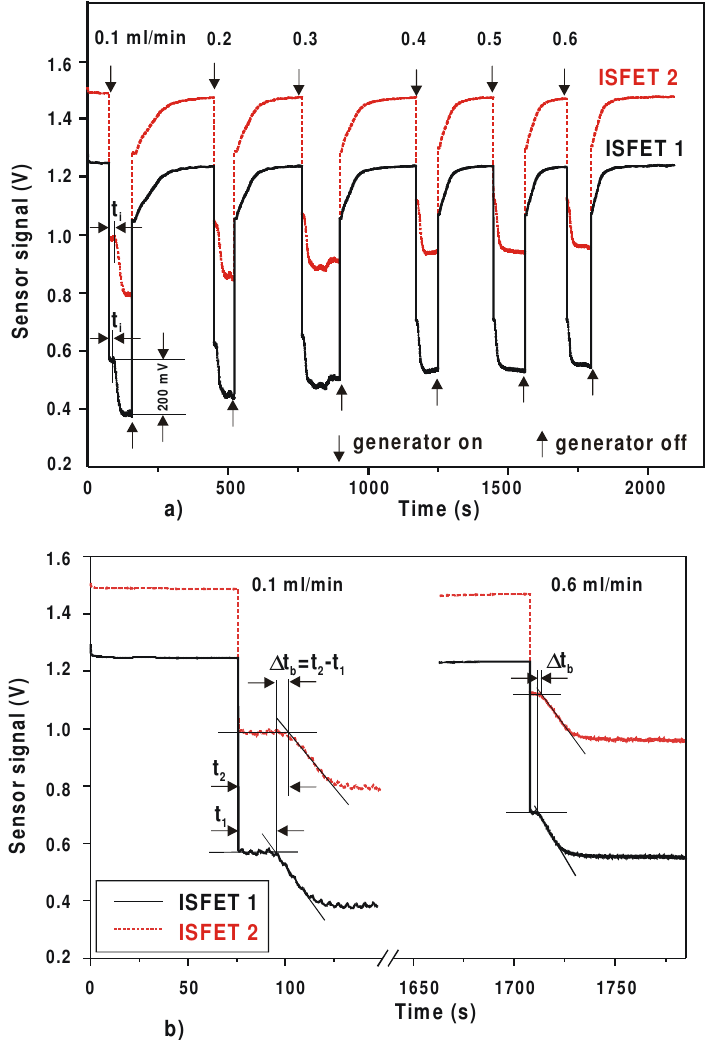
Figure 3. Typical output signal of the flow-velocity sensor consisting of two ISFETs at different flow rates from 0.1 to 0.6 ml/min (a) and determination of the time of flight (b). In this experiment, OH - -ions were generated by a constant current of 30 µA up to reach a constant sensor signal. The arrows mark the time of the beginning (arrows downwards) and the end of ion generation (arrows upwards). t : time of flight that is needed for the generated OH - -ions to “fly” from ISFET1 to b ISFET2; t : time difference between the time moments of ion generation and beginning of the i signal change of the